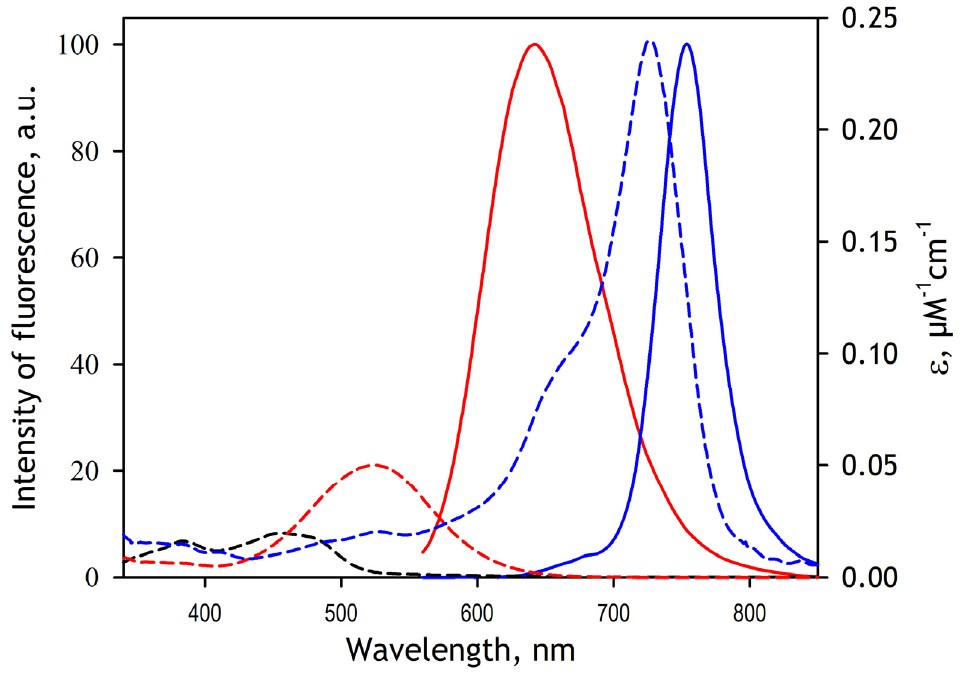
Figure A1. Spectra of absorbance (dashed lines) and fluorescence (solid lines) of DY520-XL (red) and DY731 (blue). The absorbance spectrum of SbCPR is shown in a black dashed line.